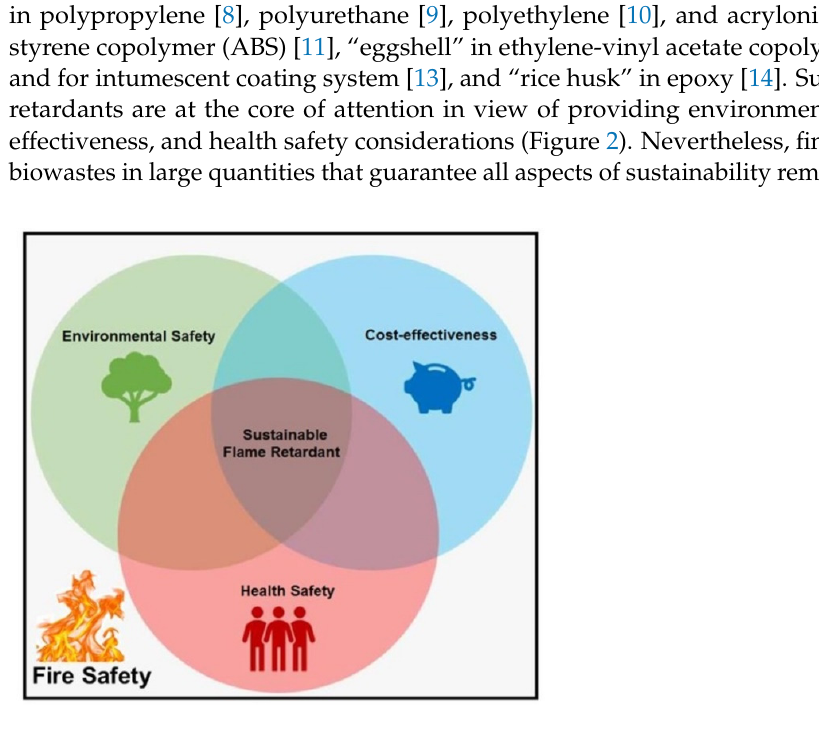
Figure 2. Schematic representation of some important parameters centered to development of sustainable flame retardants.